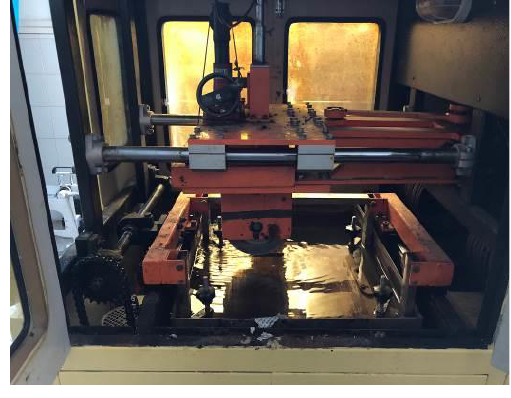
Figure 13. Abrasion tester.